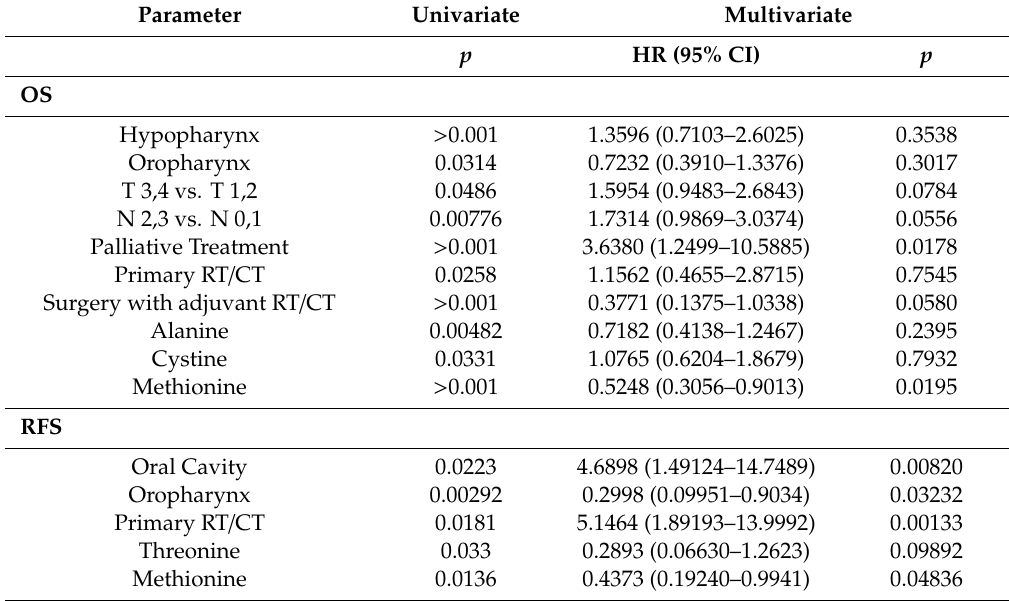
Table 2. Survival